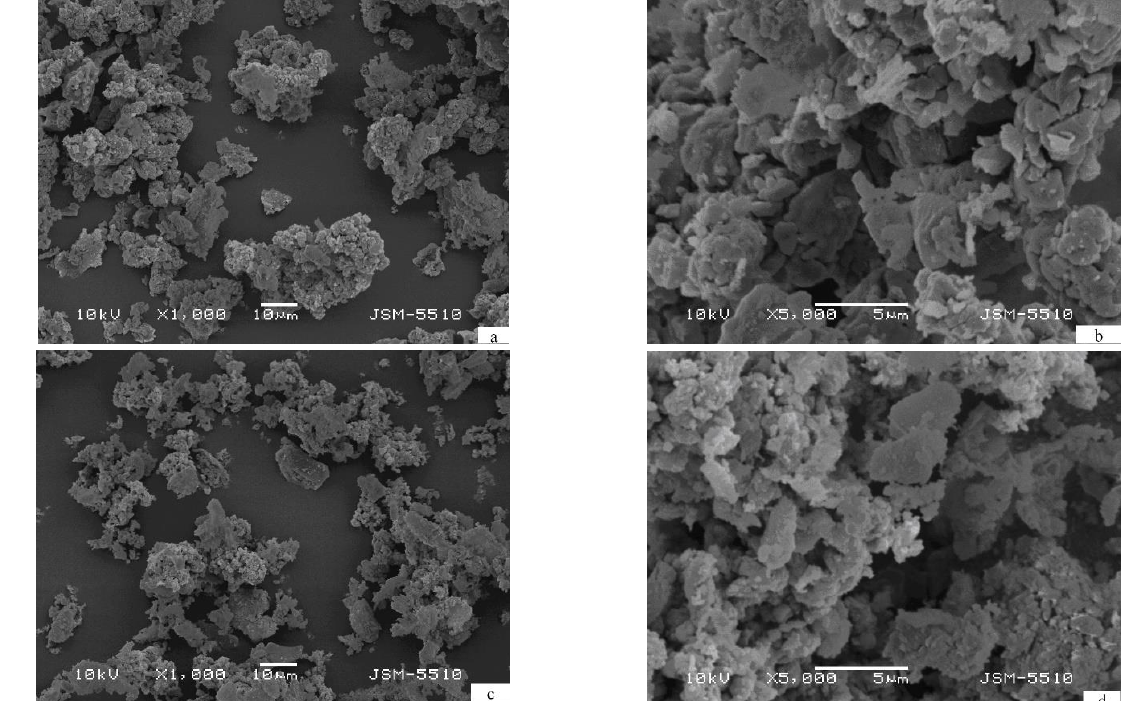
Figure 2. Scanning electron microscopy (SEM) micrographs of the composites after 10 hydriding/dehydriding cycles—( a , b ) Mg 2.1 Ni 0.7 V 0.3 —5 wt.% ACAP and ( c , d ) Mg 2.05 Ni 0.7 V 0.3 —5 wt.% ACAP.